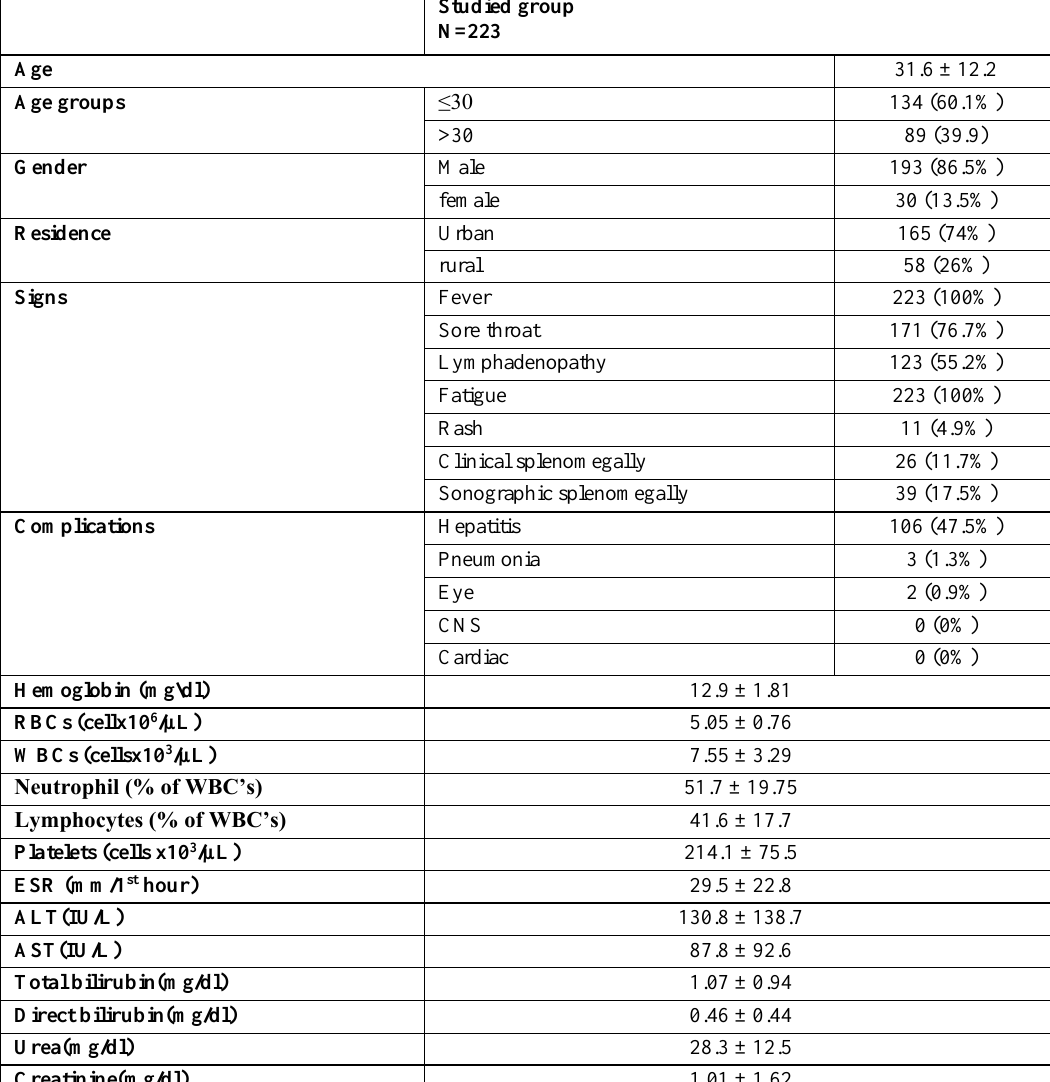
Table 1. Summary of the demographic, clinical and laboratory data of the studied population.